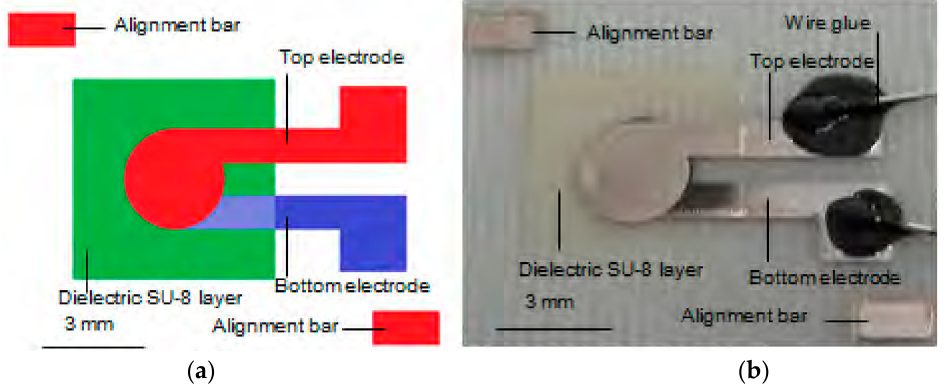
Figure 10. Top view of the fabric-based all-inkjet-printed flexible capacitor: ( a ) schematic view generated using L-Edit software; ( b ) fabricated prototype (redrawn from [25]).